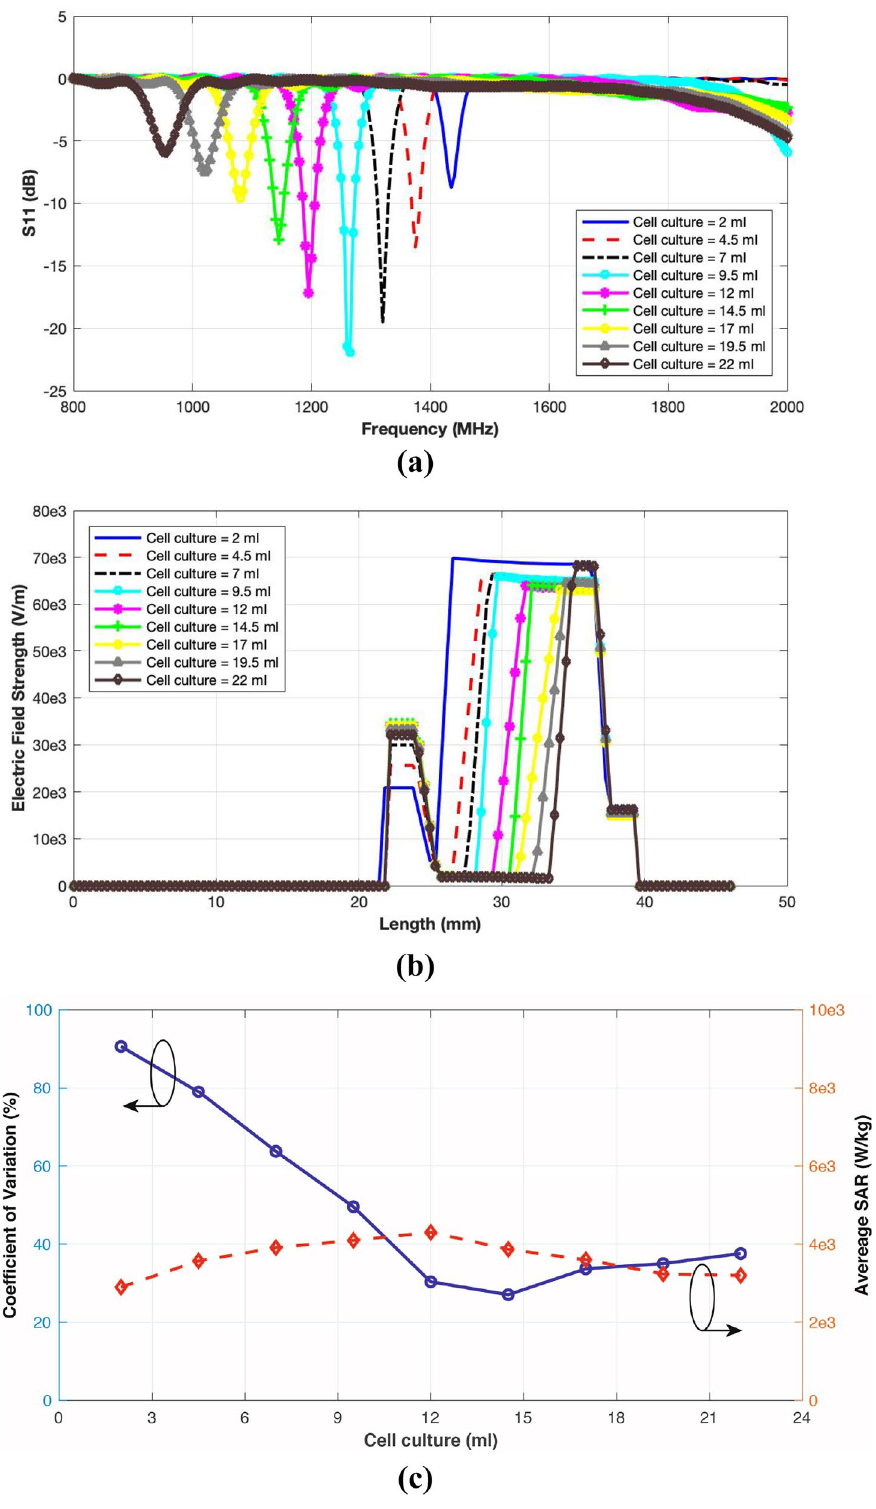
Figure 8. Performance evaluation of the designed exposure system with varying cell culture volume; ( a ) Reflection coefficient response; ( b ) Electric field strength; ( c ) SAR (average values and Coefficient of